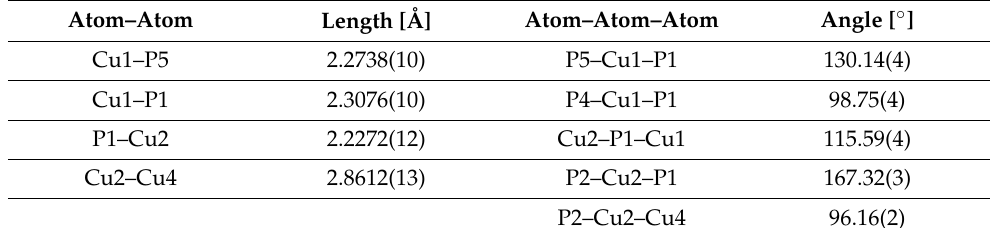
Figure 2. Cu 4 P 4 ring that is capped by a P t Bu 3 in compound 1 : ( a ) view from above the ring ( b ) view from the side. Table 1. Selected Bond Lengths (Å) and Angles (deg) for Complex 1